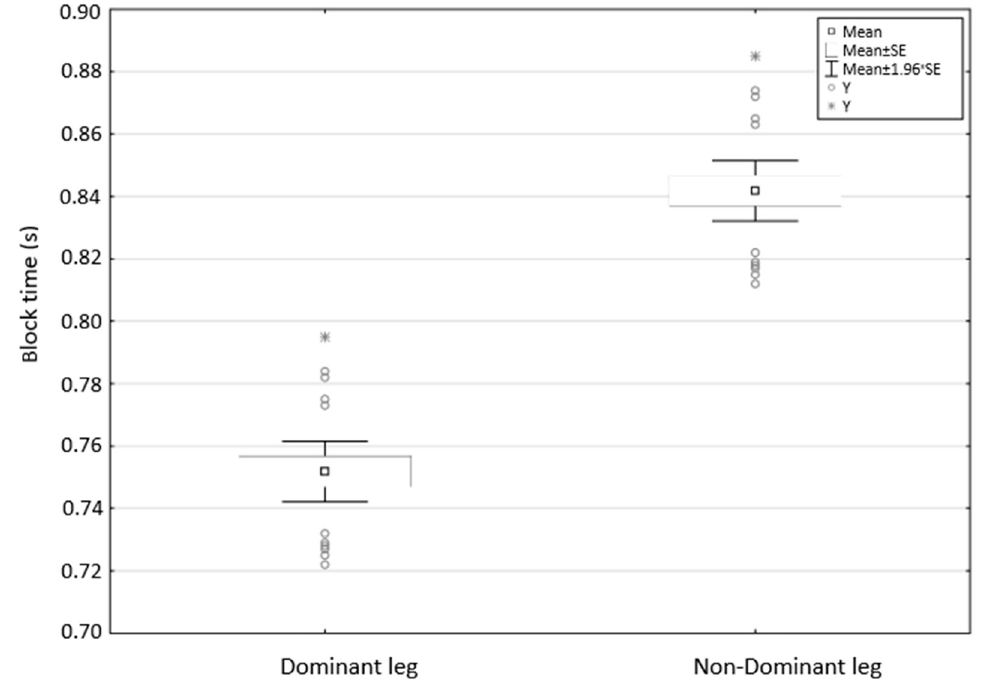
Figure 1. Dominant and non-dominant leg placed on the front edge-block time.